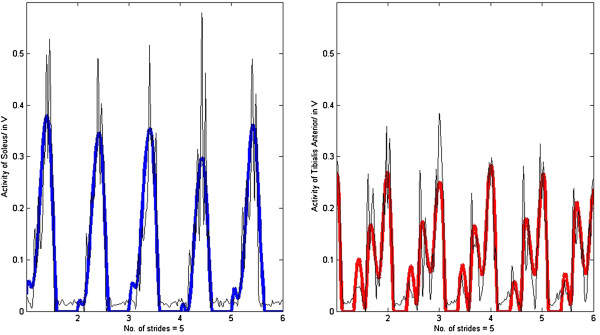
Raverage(ave) = 0.88. Muscle activation of the soleus (RSOL = 0.90) and the tibialis anterior (RTA = 0.87) of subject #1 walking at 4.5km/h with insole forces and hip angles as inputs (bold lines represent the output from the SPG model and thin lines the experimental EMG data).